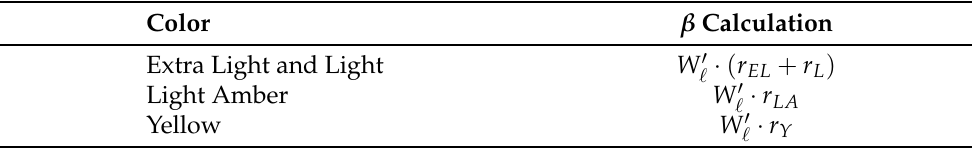
Table A2. Types of